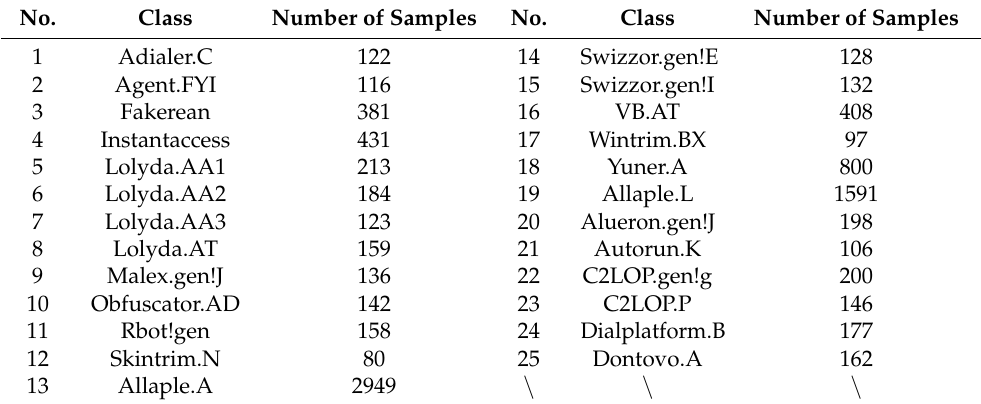
Table 3. MalImg malware image dataset.